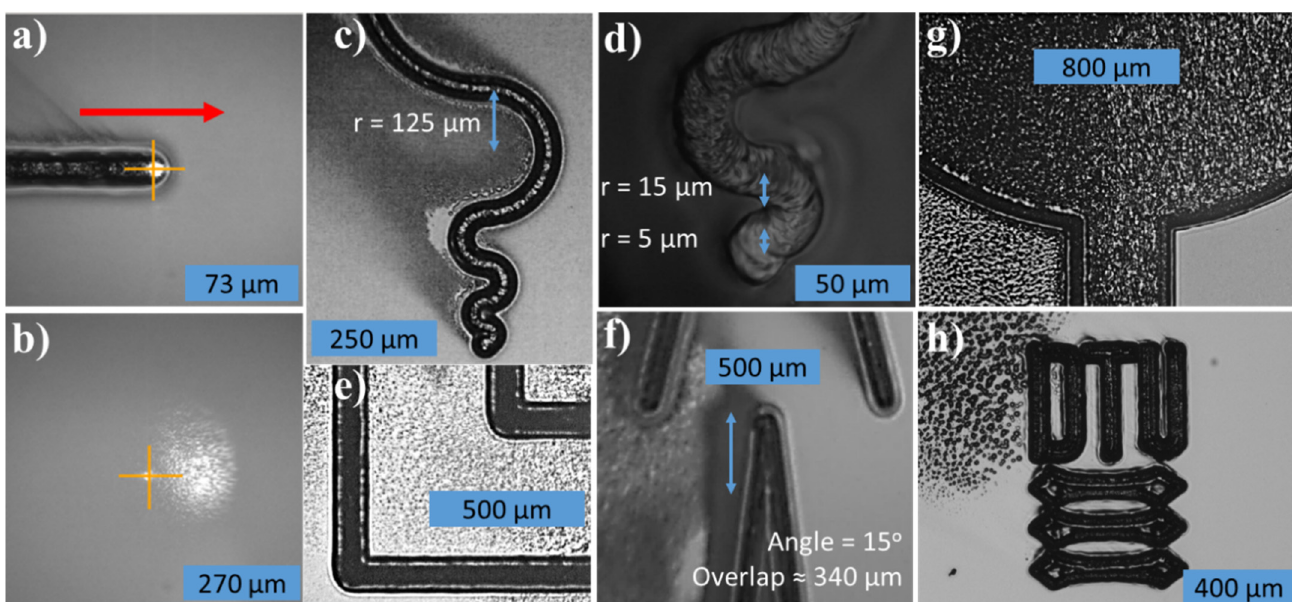
Figure 3. Direct laser writing in SU-8 with ( a ) and without ( b ) absorber. Both are written with 30 mW power and 0.5 mm/s scan speed. The red arrow on ( a ) indicates the writing direction. ( c , d ) Continuous serpentine lines written with decreasing radii of curvature (r). Lines written at 0.1 mm/s scan speed at ( c ) 30 mW and ( d ) 80 mW power. ( e , f ) Continuous lines written with a ( e ) 90° and ( f ) 15° angle. The lines were written with 80 mW power at ( e ) 2.0 mm/s and ( f ) 0.1 mm/s scan speed. ( g ) Filled circular patch, written by spacing lines closely together ( ≤ 10 µm spacing) using 80 mW laser power and 1.0 mm/s scan speed. ( h ) The logo of the Technical University of Denmark (DTU) written using 20 mW power and 0.3 mm/s scan speed.